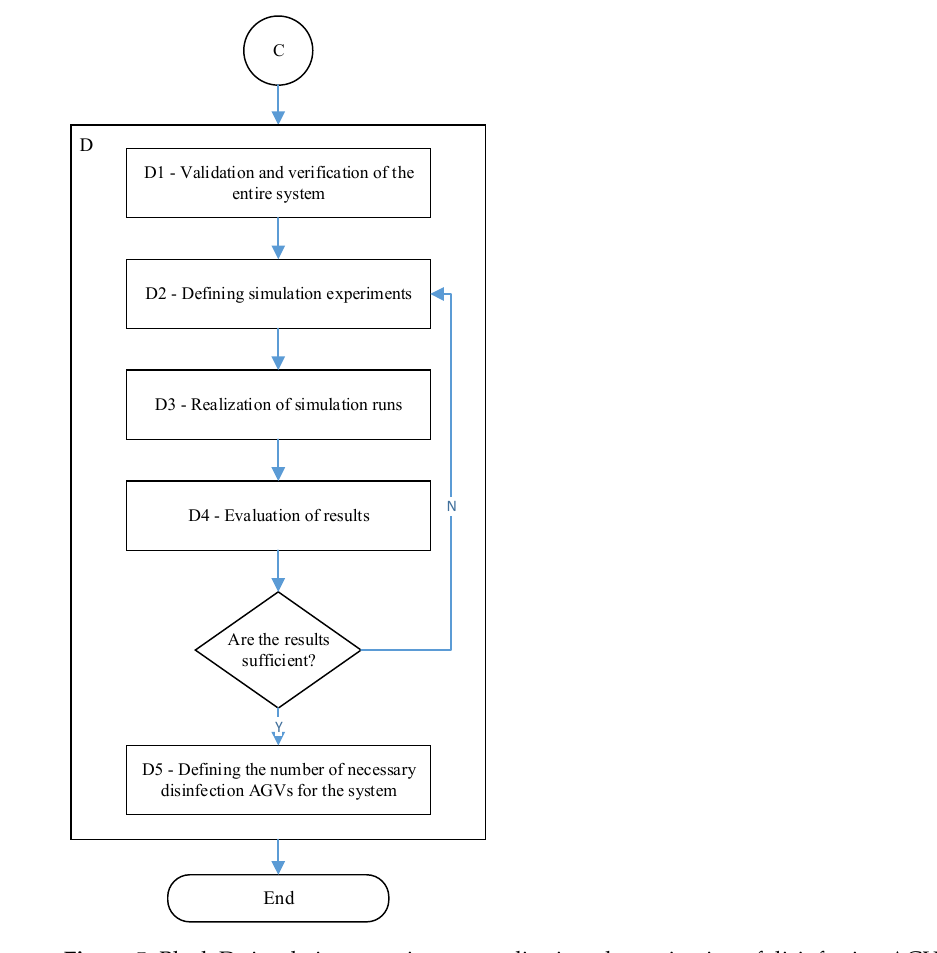
Figure 5. Block D simulation experiments: realisation, determination of disinfection AGV utilisation, and required number.